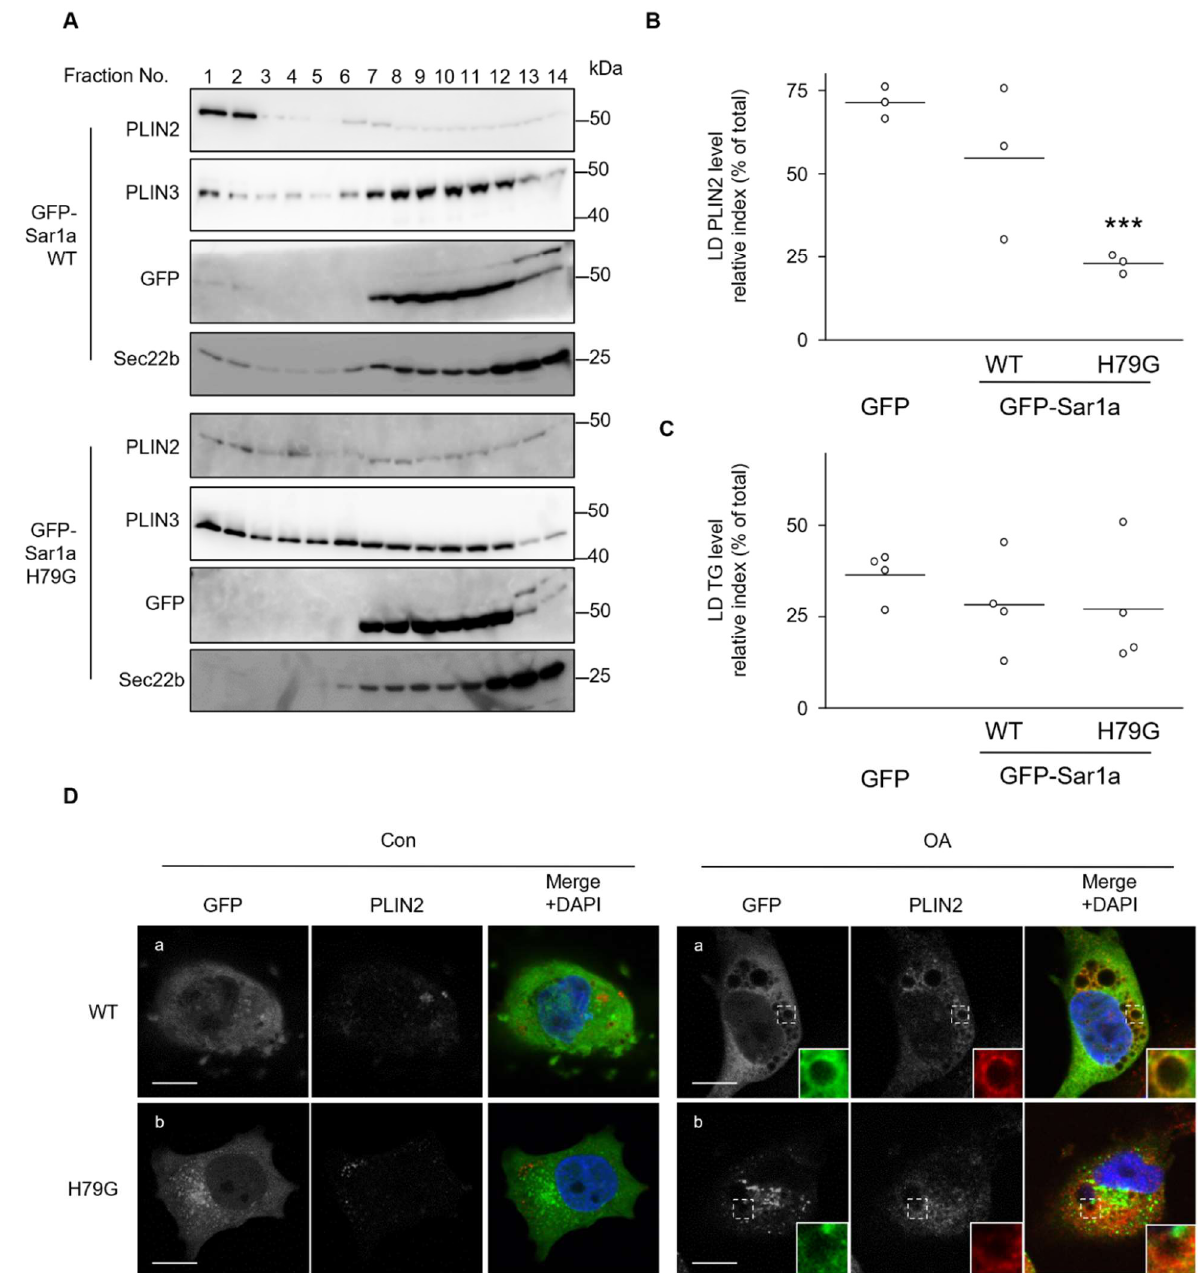
Figure 5. Effect of Sar1a on PLIN2 localization to lipid droplets. HuH7 cells transiently expressing GFP-Sar1a WT or GFP-Sar1a H79G were treated with 0.5 mM oleic acid (OA) for 24 h. ( A ) Lysates from cells containing LDs were fractionated by sucrose density gradient centrifugation, and an aliquot (10%) of each fraction was analyzed by western blotting using the antibodies against the indicated proteins. ( B ) The ratio of PLIN2 intensity in LD fractions to sum of all fractions are shown as a scattered dot plot. *** p < 0.001 (vs GFP). ( C ) The ratio of TG levels in LD fractions to total fractions is shown as a scattered dot plot. p- Values for GFP Con vs. GFP-Sar1a WT Con; and GFP vs. GFP-Sar1a were 0.518 and 0.546, respectively. ( D ) Cells expressing GFP-Sar1a WT ( a ) or GFP-Sar1a H79G ( b ) were stained with the antibody against PLIN2 and DAPI. Boxed areas are shown in higher magnification in the insets. Bar, 10 μm. Data are representative of experiments repeated at least three times.